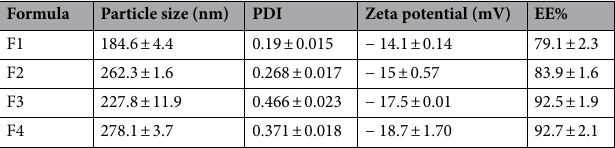
Table 3. Summary of the results obtained for all the prepared